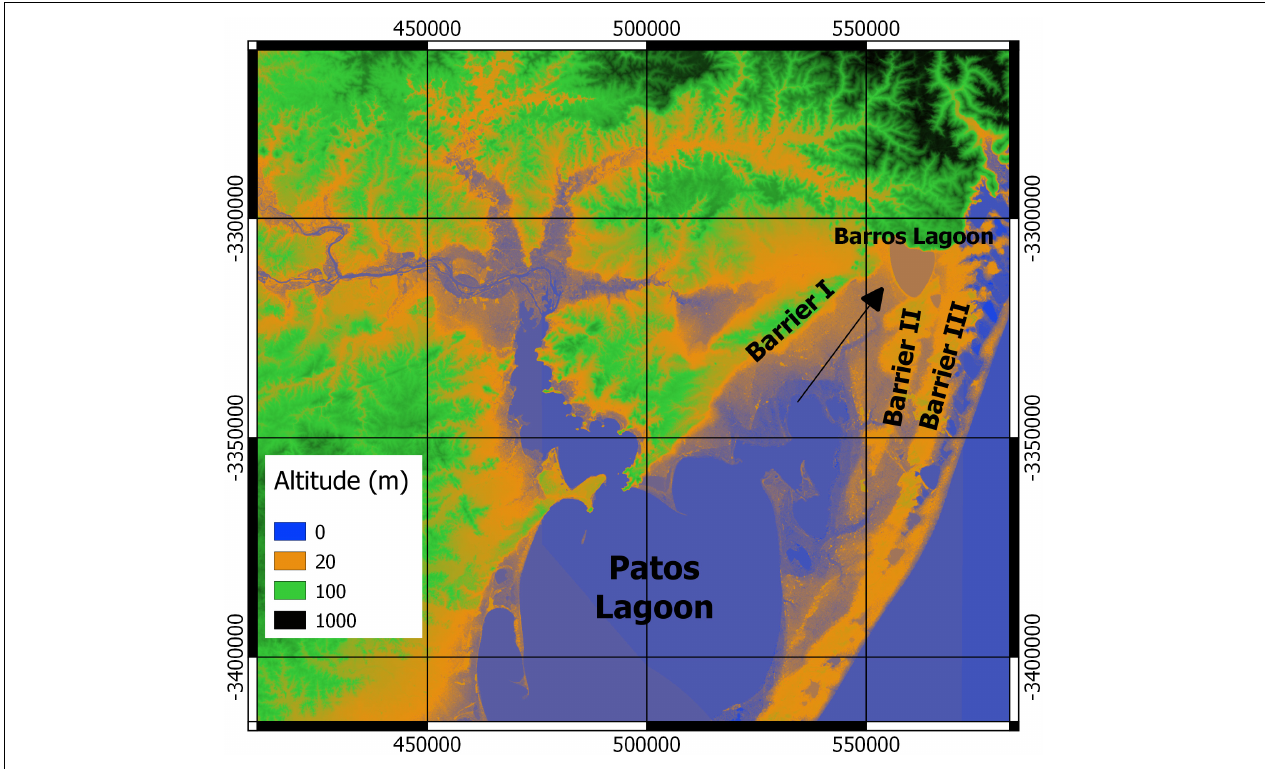
FIGURE 10 | Northern Patos Lagoon and depositional sand barriers from marine transgressions and regressions during the Pleistocene. Barriers I, II and III were formed at 325, 230 and 125 thousand years, respectively (Rosa et al., 2017). Arrow indicates a possible connection between Patos Lagoon and Barros Lagoon through lowland areas. Digital Elevation Model at 30 × 30 m resolution (EPSG:32622 – WGS 84/UTM zone 22N –